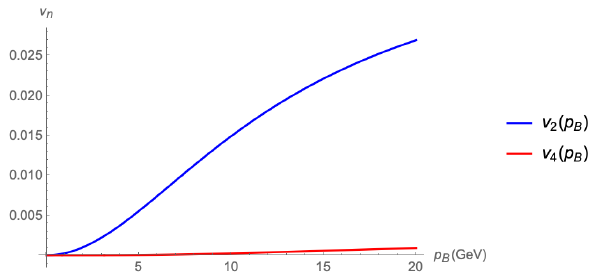
Figure 1. Elliptic flow v 2 and quadrangular flow v 4 of bottomonia as a function of transverse momentum for initial eccentricities (cid:101) 2 equal to